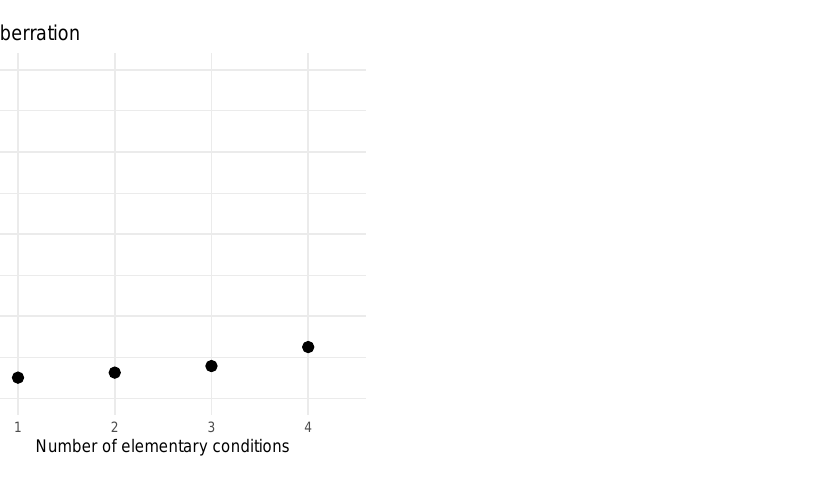
Figure 6. Odds ratio values for the for the premise of the positive rules with successive elementary conditions